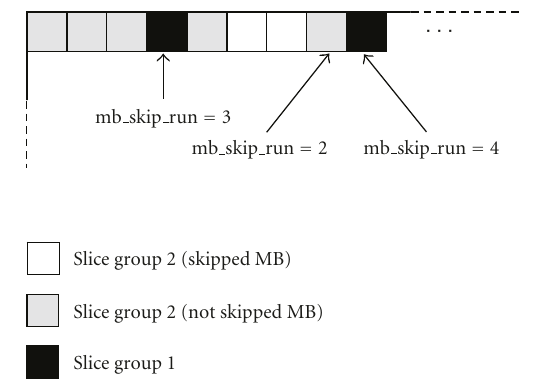
Figure 3: An example of macroblock to slice group map coded via mb skip run syntax.